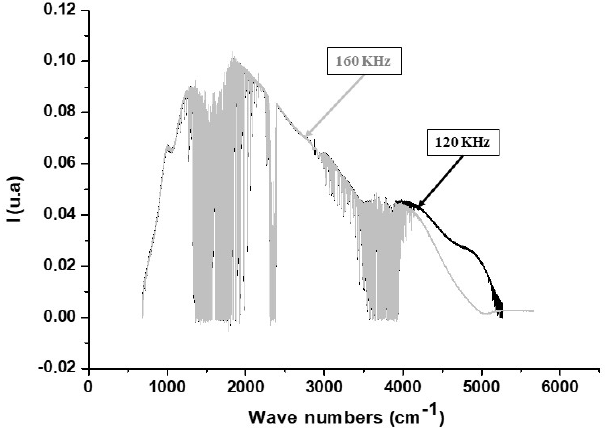
Figure 5. Spectra of the external blackbody with two different scan- ning velocities: 120KHz (black) and 160KHz (light gray).